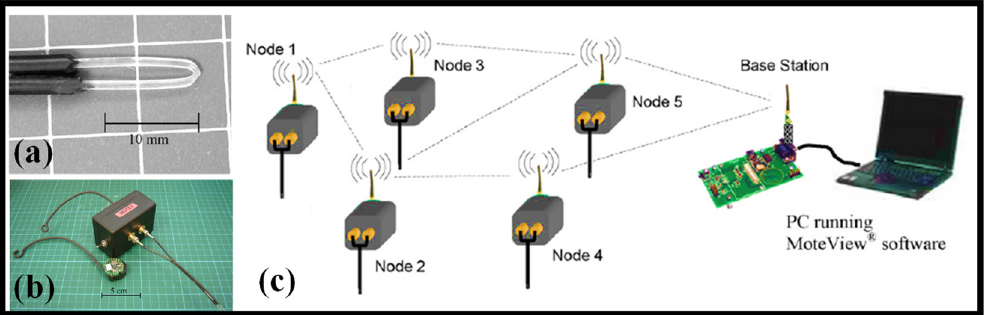
Figure 10. Flood monitoring ( a ) image of the modified U-shaped sensor profile [178], ( b ) photo of the wireless POF prototype and the MICA2DOT unit [178], ( c ) representation of the universal wireless POF sensor system [178].